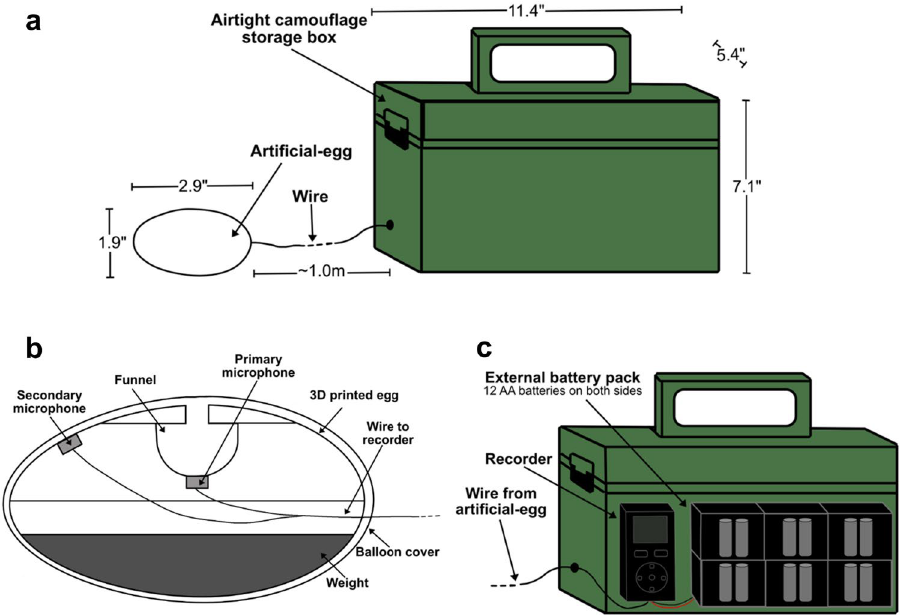
Figure 4. Schematics of ( a ) an artificial-egg heart-rate monitor, ( b ) the interior of the artificial-egg and ( c ) the interior of the airtight camouflage storage